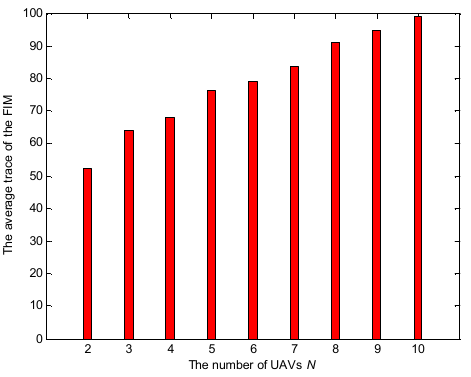
Figure 40. The average trace of the FIM for different numbers of UAVs (Scenario 5).